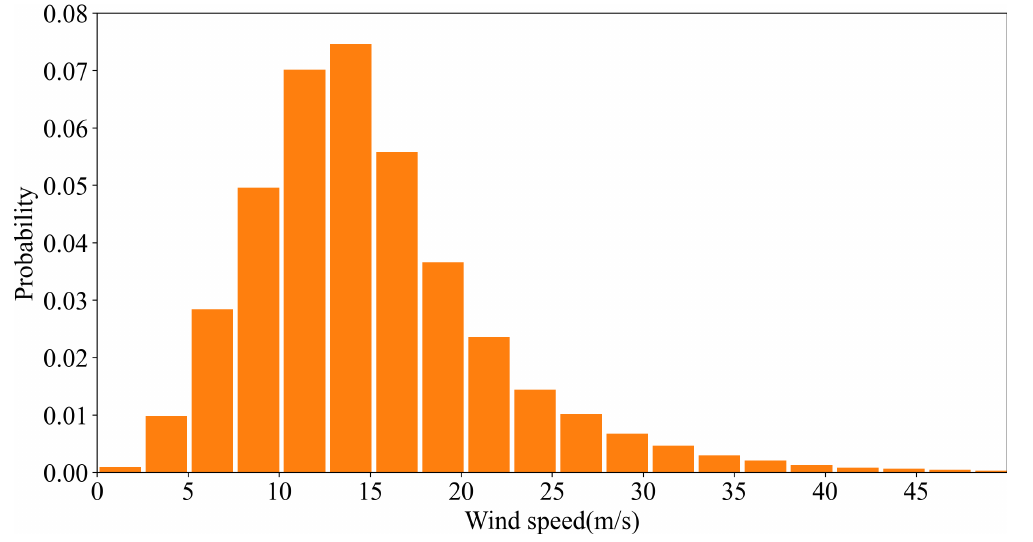
Figure 4. Two-dimensional histogram of collocations between HY-2B/C/D and SMAP in the range of 0–50 m/s.